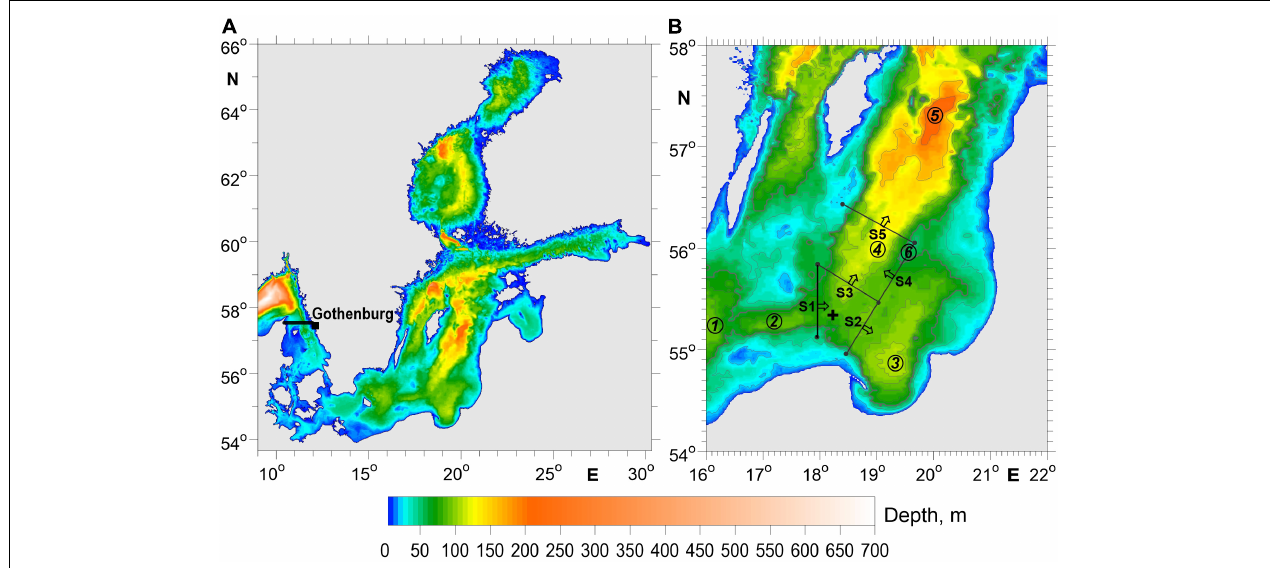
FIGURE 1 | (A) Bathymetric map of the Baltic Sea. The model domain has an open boundary close to Gothenburg (the bold black line). (B) Close-up of the southeastern Baltic Sea. The encircled numbers 1–6 point at the Bornholm Basin ( 1 ), the Słupsk Furrow ( 2 ), the Gda´nsk Basin ( 3 ), the Hoburg Channel ( 4 ), the Gotland Deep ( 5 ), and the Klaipeda Bank (6). The black lines labeled S1–S5 are the locations of 5 cross-sections through which the saltwater transport is calculated. The arrows at the cross-sections show the direction corresponding to the positive value of the saltwater transport. The black cross points at the location of the IOW monitoring station